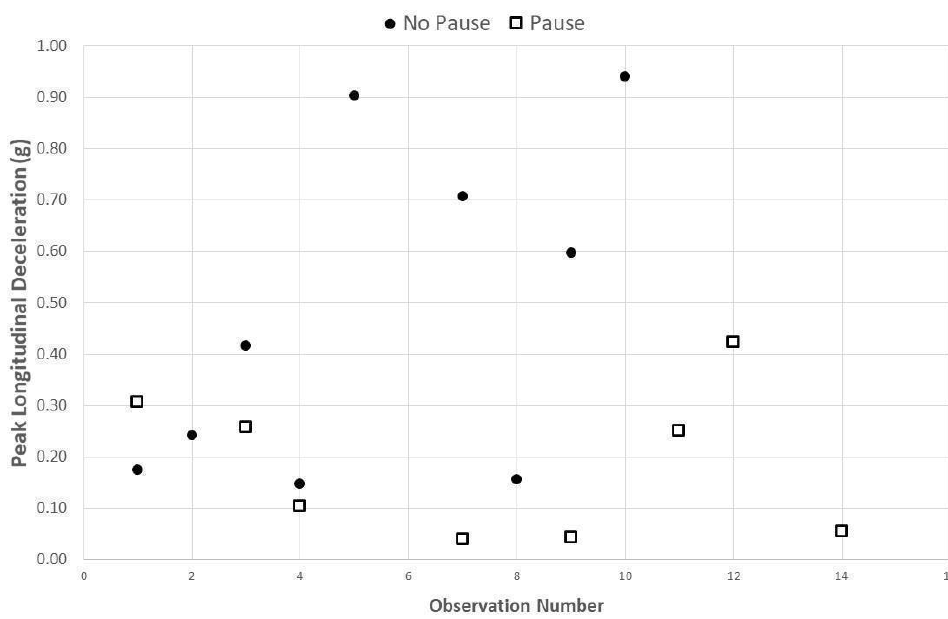
Figure 11. Scatterplot of peak longitudinal acceleration by experimental condition.